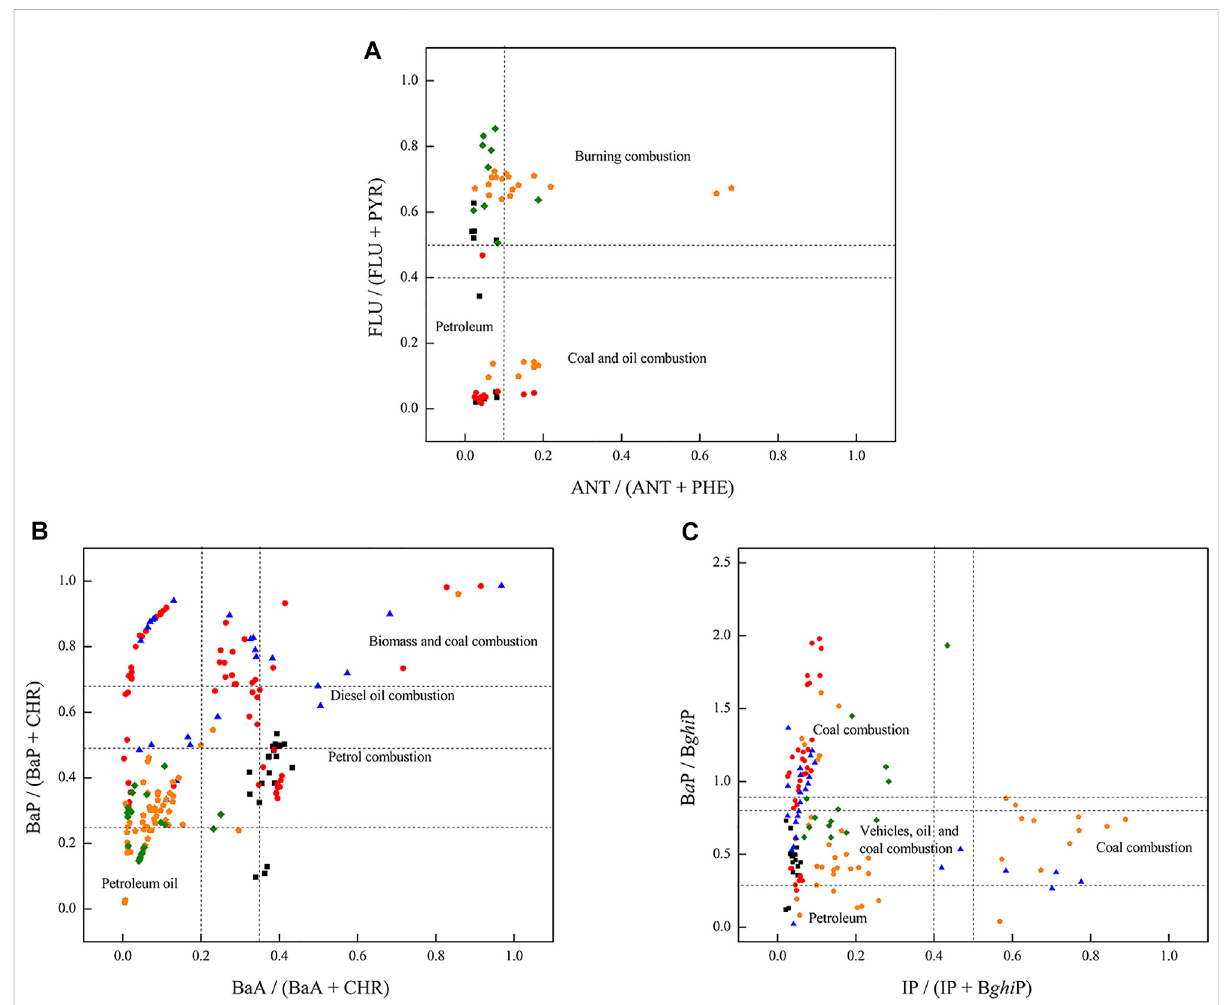
FIGURE 4 Cross plot distribution of PAH characteristic ratios from 2018 to 2022. 2018, black square; 2019, red circle; 2020, blue triangle; 2021, orange pentagon; and 2022, green diamond. (A) FLU/(FLU + PYR) vs. ANT/(ANT + PHE); (B) BaP/(BaP + CHR) vs. BaA/(BaA + CHR); (C) BaP/BghiP vs. IP/(IP +